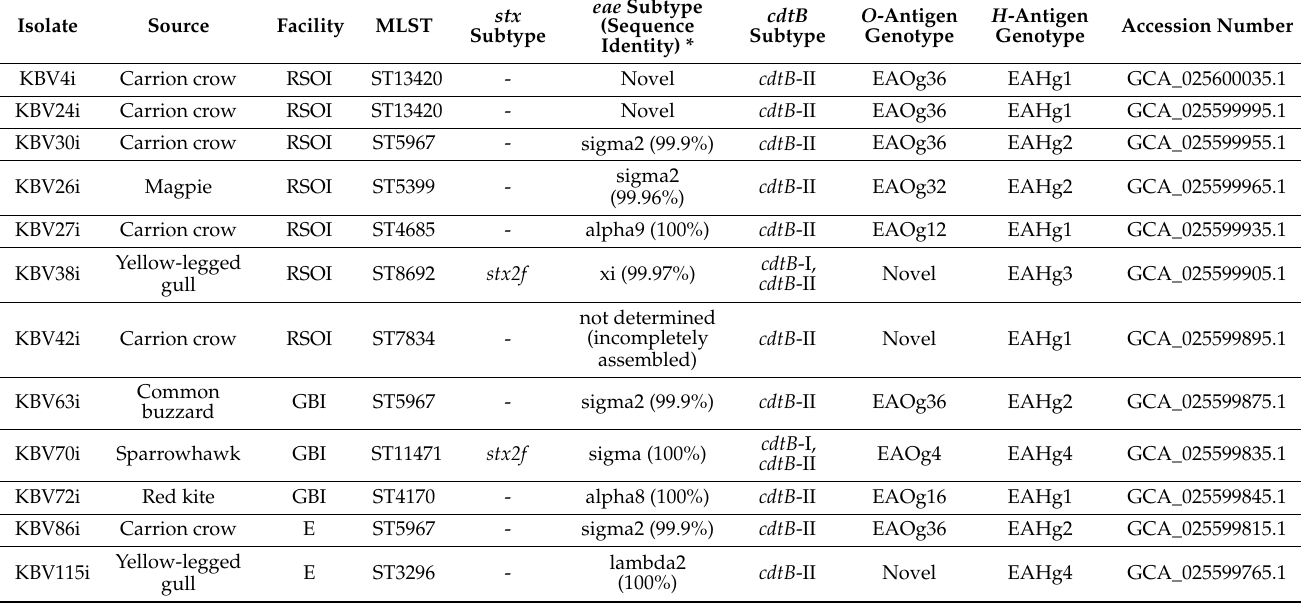
Table 2. Sequence types and presence of stx, eae subtype, cdtB subtype, and O - and H -antigen subtypes in E. albertii genome